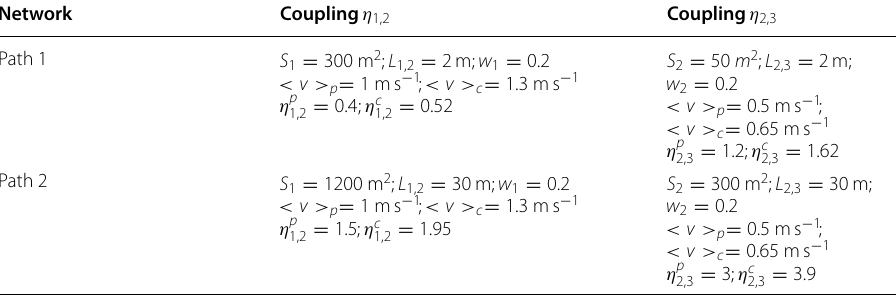
Table 4 Coupling setup. Here two networks are considered, the ones labelled Path 1 and Path 2 in Fig. 6